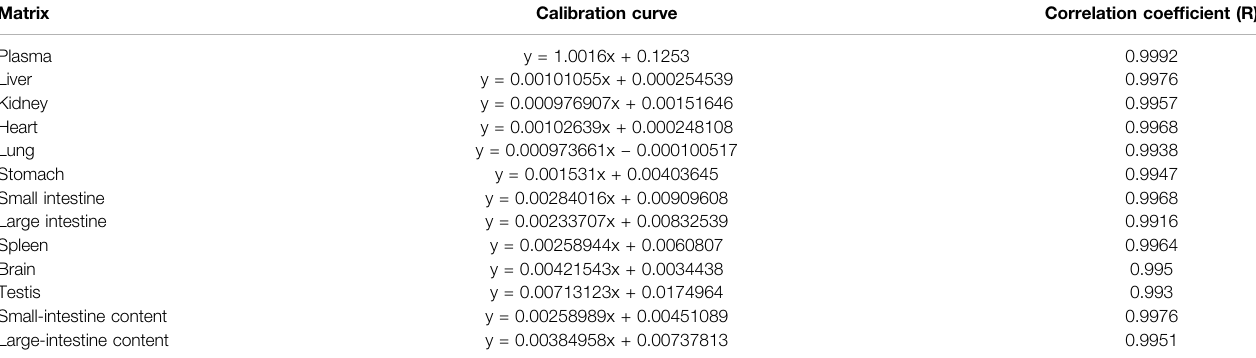
TABLE 1 | Calibration curve and correlation coef fi cients of Indo5 in biological samples.